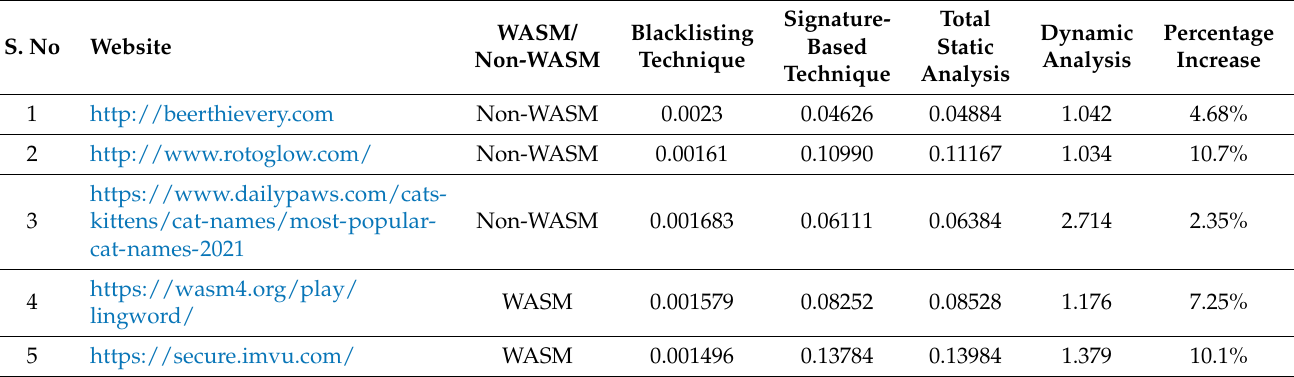
Table 5. Performance Evaluation (in